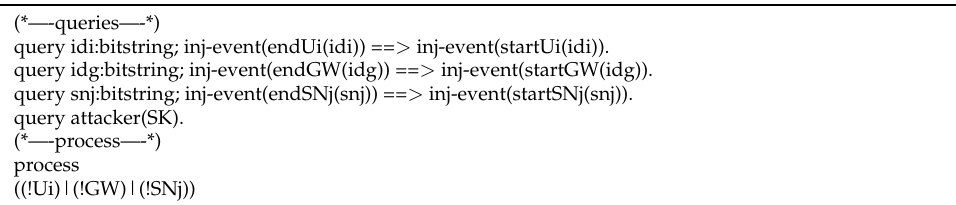
Table 9. Queries and main